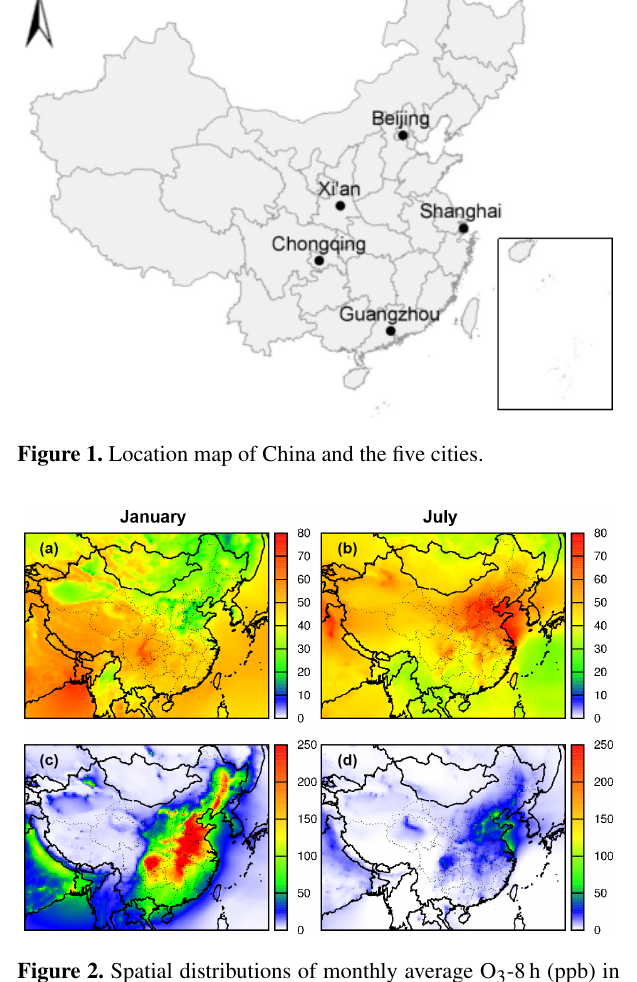
Figure 2. Spatial distributions of monthly average O 3 -8h (ppb) in (a) January and (b) July and monthly average PM 2 . 5 (µgm − 3 ) in (c) January and (d) July 2013.